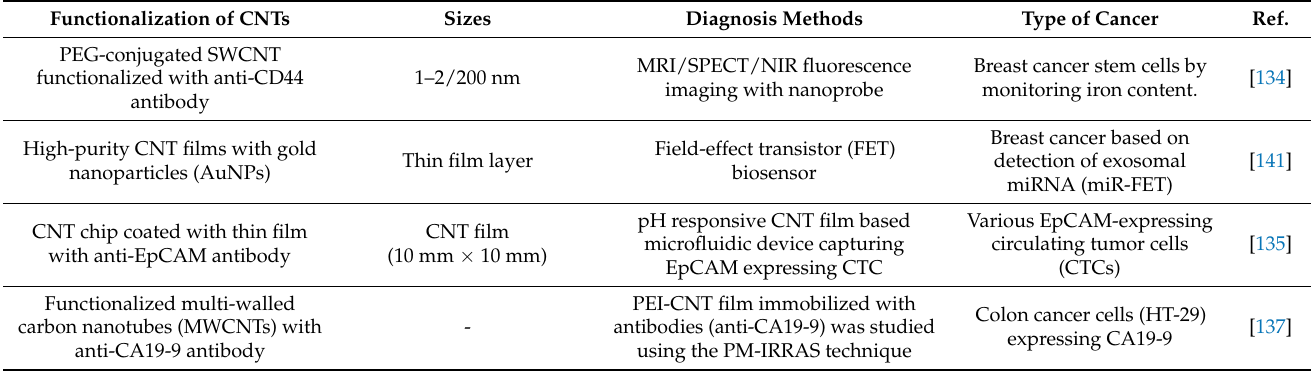
Table 1. Summarization of CNTs and their derivatives as biosensors for cancer detection.